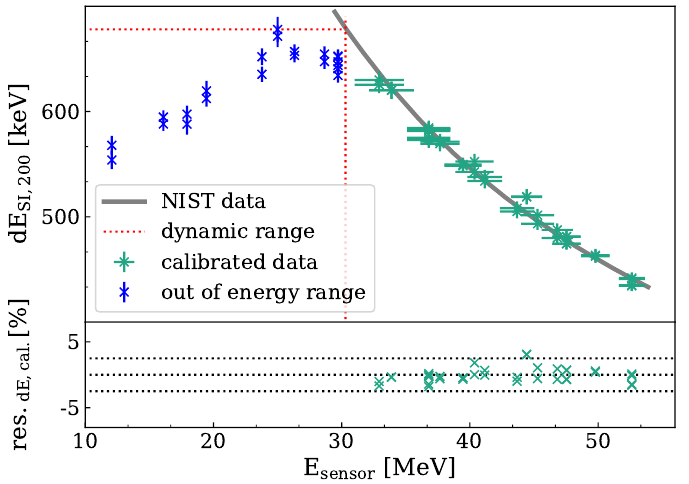
Figure 12. Calibrated results of the mean deposited energy dE SI,200,cal and their relative deviation from the NIST expectation. The minimum energy E sensor, min = 30.4MeV measurable with this configuration of the detector and the resulting data, which had to be excluded from the analysis, are